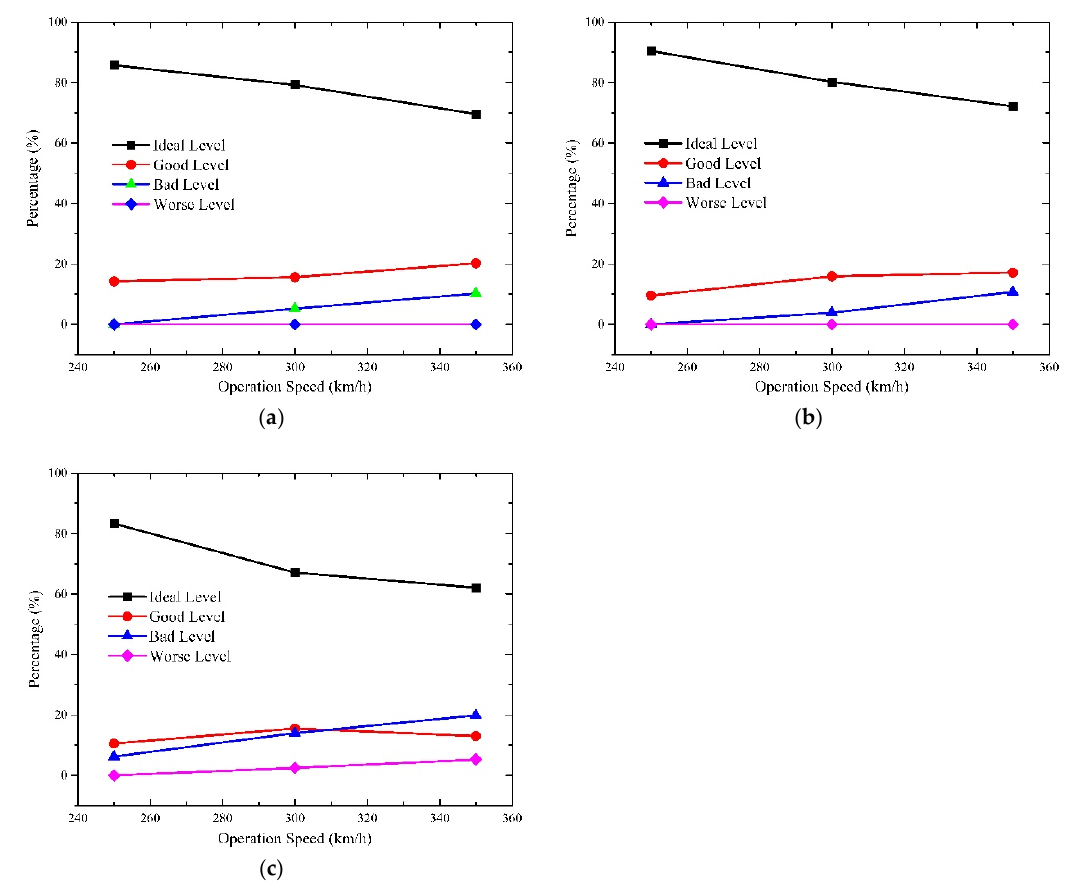
Figure 9. The relationship between operation speed and aural discomfort; (a) I1; (b) I2; (c) I3.